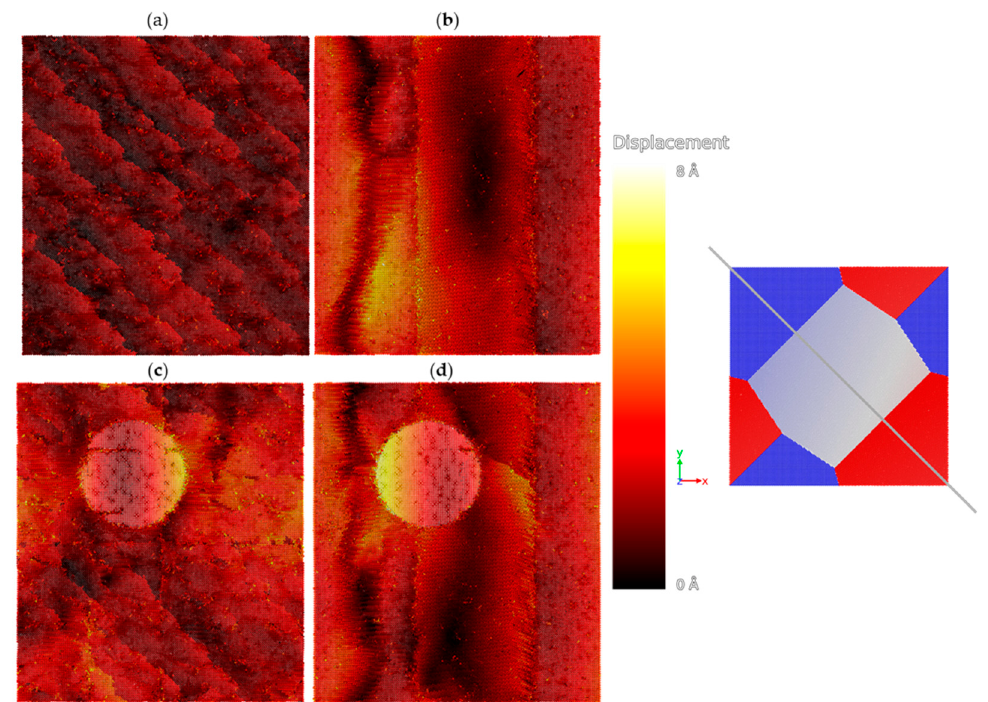
Figure 7. Atomic rearrangement (displacements) after the initial stage of compression in low- ( a,c ) and high-misorientation ( b,d ) grains of the unalloyed ( a,b ) and alloyed ( c,d ) system.